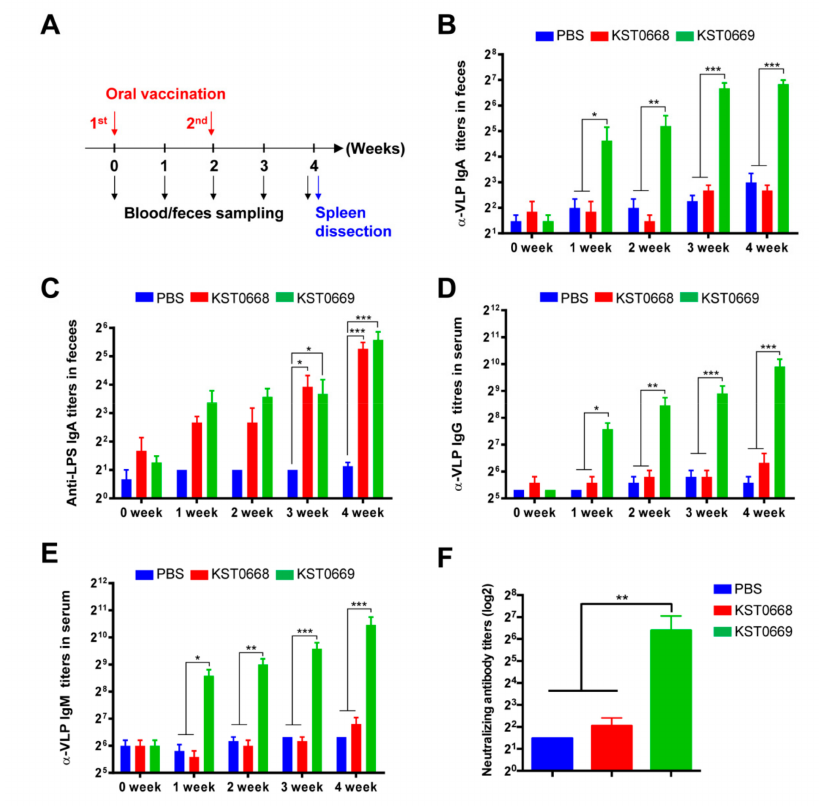
Figure 4. Humoral and mucosal immune responses induced by immunization with KST0669. ( A ) Schematic of the mouse experiment schedule. Mice ( n = 5 per group) were orally administrated 1 × 10 8 CFU KST0668 or KST0669 twice at 2-week intervals, and feces and sera were collected weekly for 4 weeks. ( B , C ) VLP FMDV -specific ( B ) or Salmonella LPS-specific ( C ) IgA in feces. VLP FMDV (2 µ g/mL) and Salmonella LPS (1 µ g/mL) were immobilized on 96-well plate and IgA titer was measured by ELISA. ( D,E ) The serum levels of VLP FMDV -specific IgG ( D ) and IgM ( E ) were measured weekly. Data are expressed as mean ± SEM per group and analyzed by two-way ANOVA followed by a post-hoc Tukey test. ( F ) Neutralizing activity of FMDV in sera from PBS-, KST0668-, and KST0669-vaccinated mice. Pooled sera from immunized mice ( n = 5 per group) at day 14 after the last vaccination were serially diluted and incubated with FMDV followed by incubation with BHK-21 cells. Cytopathic effects of the sera were measured 72 h after incubation. Data are expressed as mean ± SEM per group and analyzed by unpaired t test. *** p < 0.005, ** p < 0.01, and * p < 0.05. α -VLP: